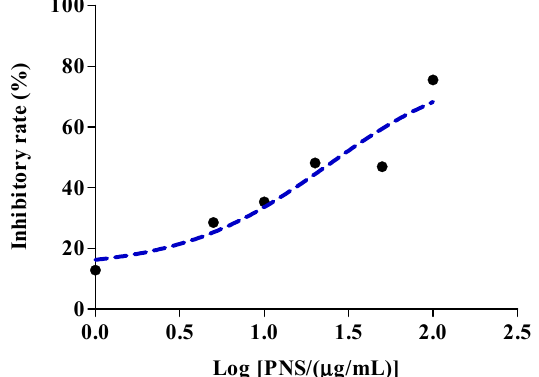
Figure 3. Various concentrations of PNS were used to measure the half inhibition concentration toward hCE2. Each point represents the mean of three independent experiments.